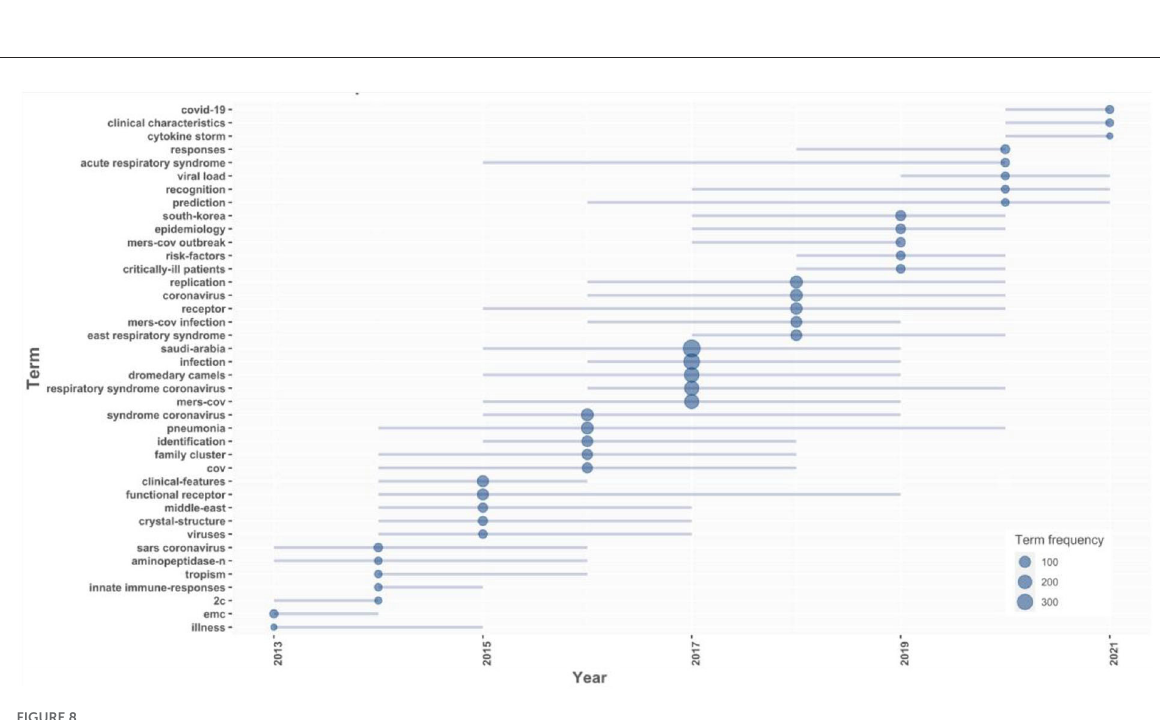
FIGURE8 Trend topics in MERS-CoV over the years